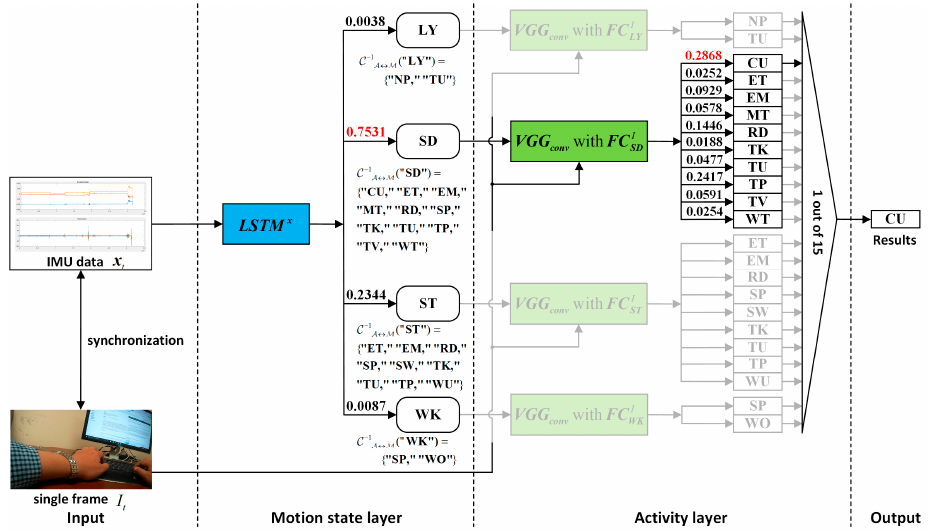
Figure 8. A specific fusion example of the proposed hierarchical deep fusion framework applied to the self-built eButton hybrid dataset.